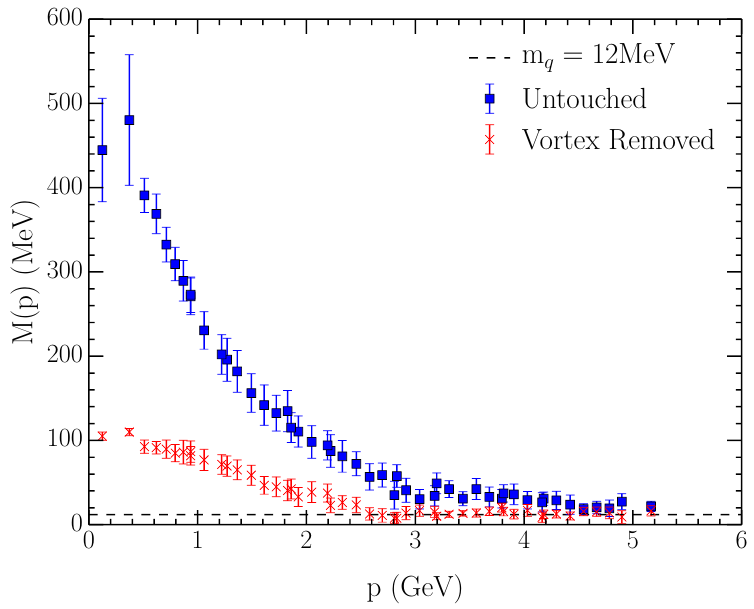
Figure 6. The mass function of the effective quark propagator computed accounting for the full and vortex-removed configurations. The figure is taken from Ref.